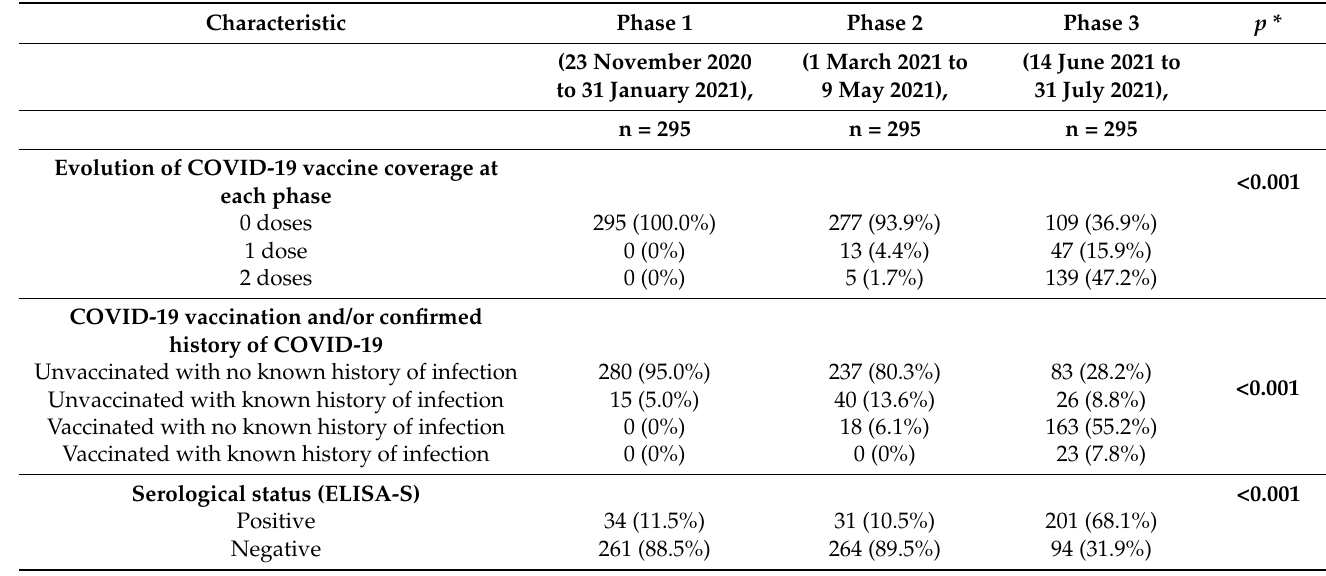
Table 2. Clinical characteristics of the study